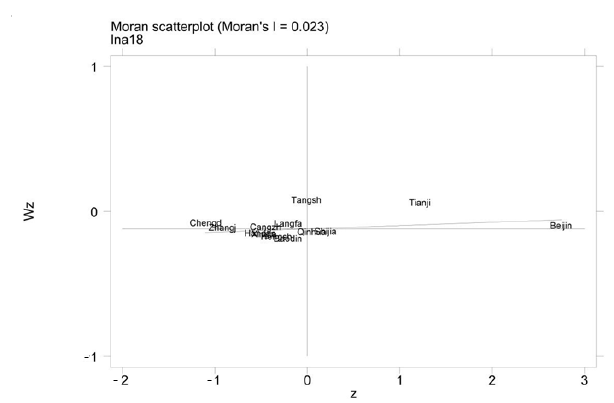
Figure 1. Local Moran’s I index